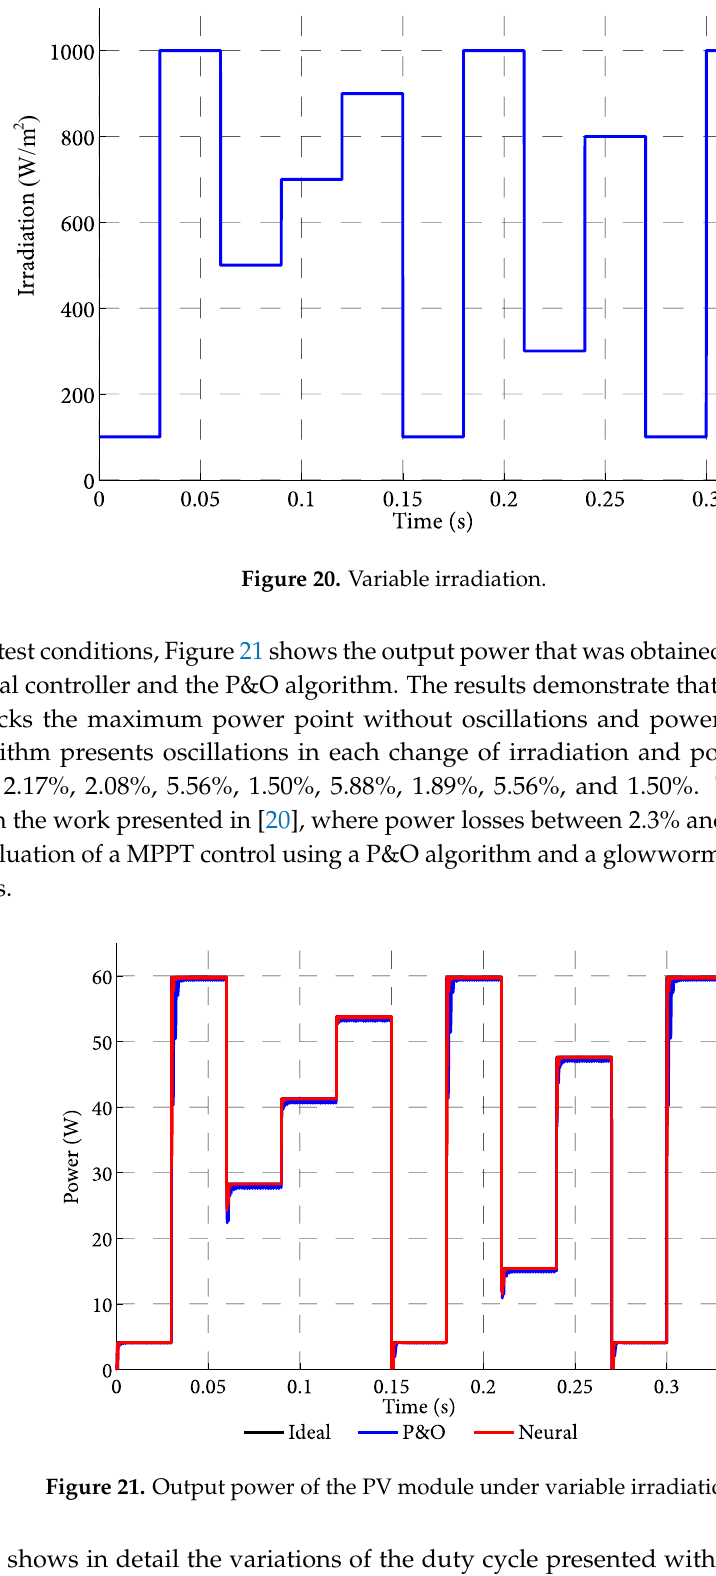
Figure 19. Output power of the PV module for an irradiation change from 100 to 1000 W/m 2 , 50 °C. A constant temperature of 50 °C and an irradiation signal with sudden changes over seven possible values, at 0.03 s, 0.06 s, 0.09 s, 0.12 s, 0.15 s, 0.18 s, 0.21 s, 0.24 s, 0.27 s, and 0.30 s, were used to evaluate the performance of the system. See Figure 20.